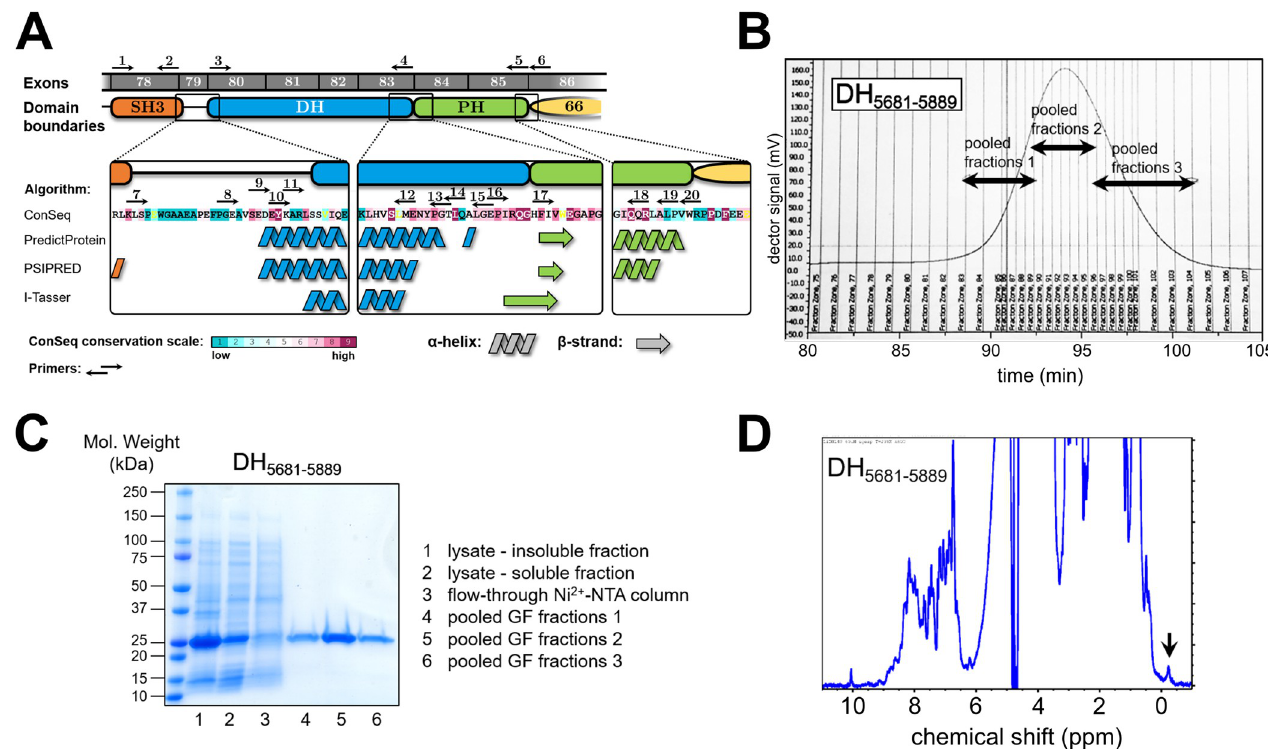
Fig 1. Design and purification of obscurin RhoGEF fragments. A, obscurin RhoGEF region. Exon boundaries and bioinformatic analysis and structure prediction based on amino acid sequence of human obscurin B isoform (NCBI ref. seq. NM_001098623). B, gel-filtration elution profile of DH domain fragment comprising residues 5681–5889. C, SDS-PAGE analysis of samples at different steps of the purification process of the DH 5681-5889 fragment. D, 1D-NMR analysis of purified DH 5681-5889 fragment. NMR spectrum exhibits wide peak dispersal and peaks below 0 ppm (black arrow), indicating that the protein is